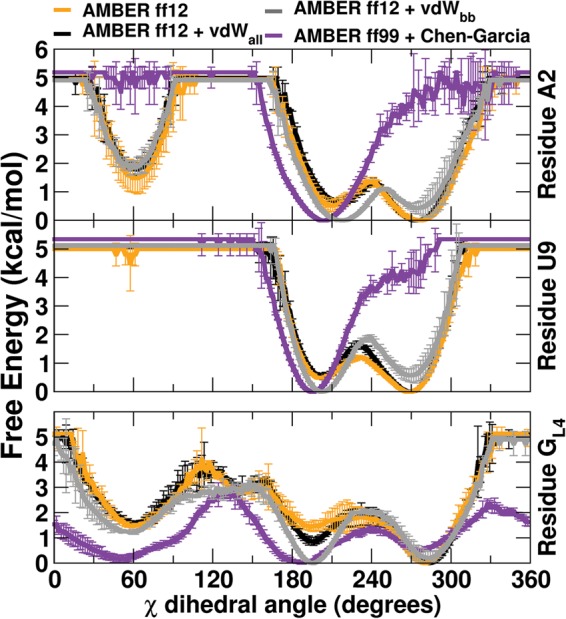
Free energy versus χ dihedral angle distribution at 277 K for the A:U stem base pair (top) and GL4 residue (bottom) for four force fields. Syn minimum is 60°, anti minimum is 180–240°, and high anti is 270°. Data are the average of two independent runs with error bars representing standard deviation.